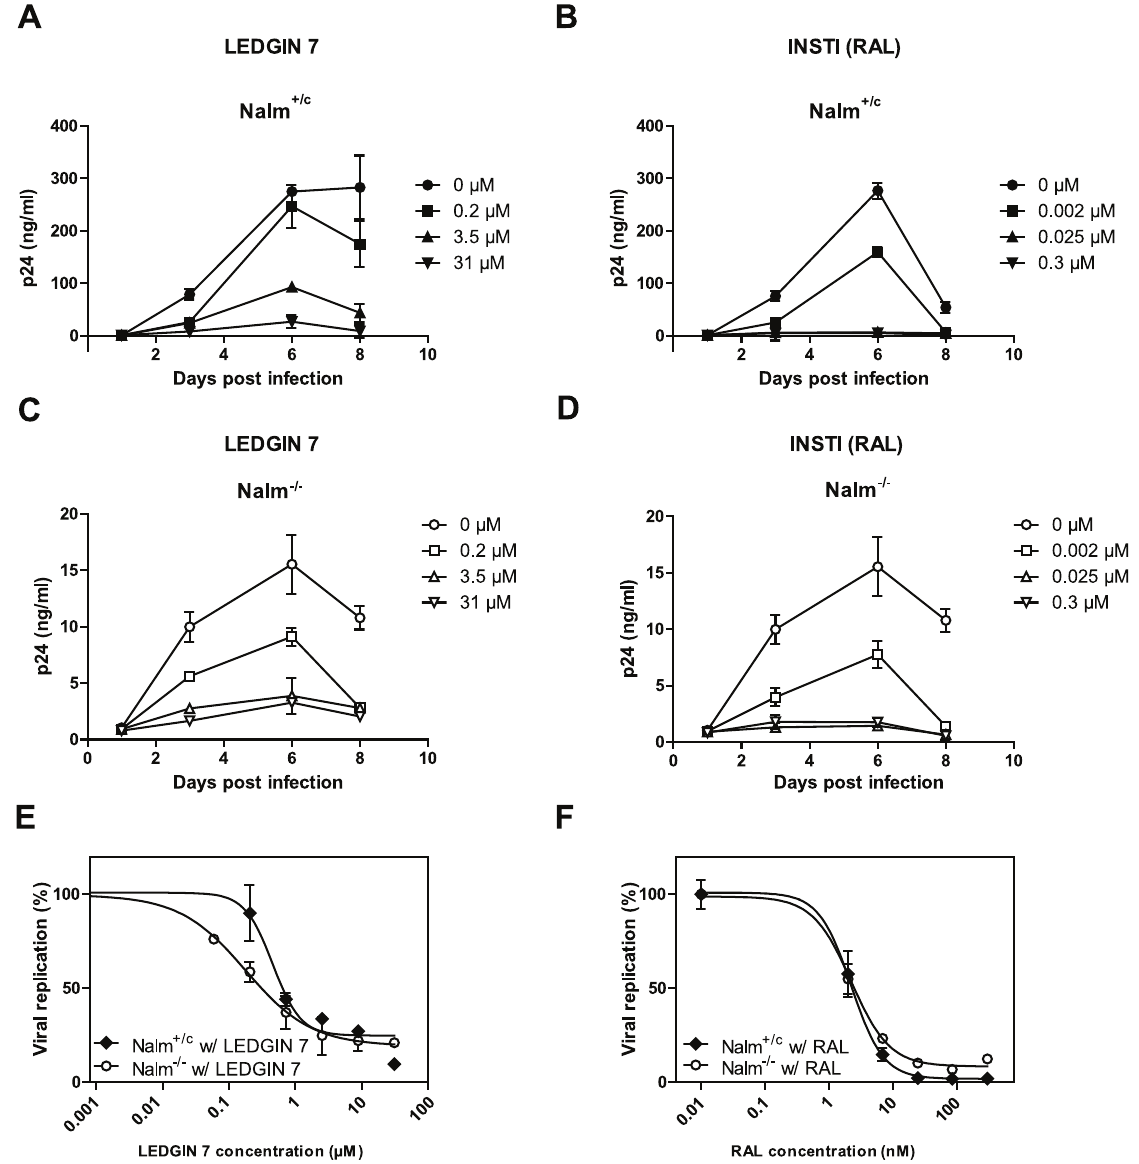
Figure 5. LEDGINs block residual HIV-1 replication in LEDGF/p75 KO cells. Nalm + /c and Nalm 2 / 2 cell lines were challenged with HIV IIIb in the presence of varying concentrations of HIV inhibitors. Supernatant was harvested for p24 ELISA. (A,C) LEDGIN 7 was added at different concentrations (0 m M, circles; 0.2 m M, squares; 3.5 m M, triangles or 31 m M, triangles pointing downwards). (B,D) Identical conditions were used as shown in (A,C), but the INSTI raltegravir (RAL) was added at different concentrations (0 m M, circles; 0.002 m M, squares; 0.025 m M, triangles or 0.3 m M, triangles pointing downwards). (A–D) Averages from duplicate experiments 6 standard deviations are shown. (E) Dose-response curves in Nalm + /c and Nalm 2 / 2 cell lines were generated from p24 ELISA values obtained at day 6 for LEDGIN 7 concentrations of 0 m M, 0.06 m M, 0.2 m M, 0.7 m M, 3.5 m M, 8.9 m M, 31 m M. Data are fitted to a sigmoidal dose-response (variable slope) curve, from which IC 50 values were calculated (Table S1). (F) In analogy with (E), p24 values obtained at day 6 for RAL were plotted to enable determination of IC 50 . RAL was used in concentrations of 0 m M, 0.002 m M, 0.007 m M, 0.02 m M, 0.08 m M and 0.3 m M.